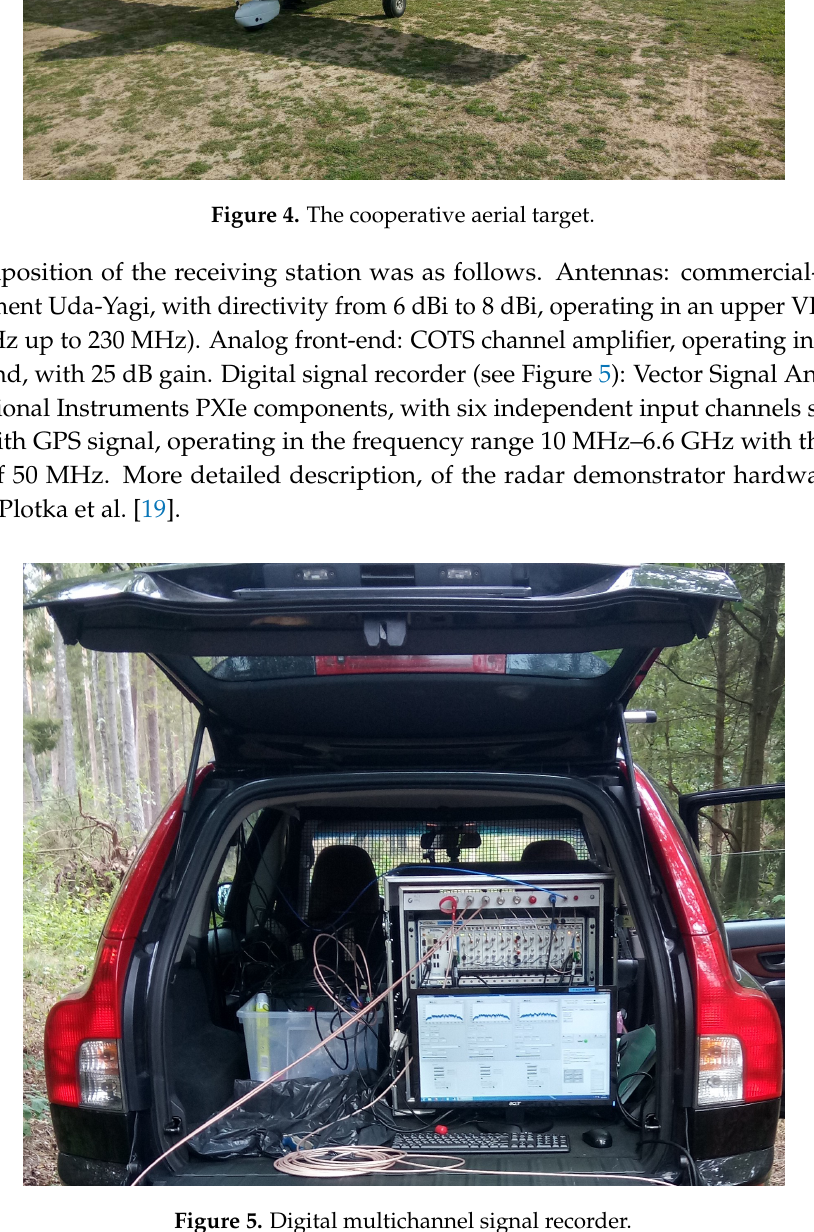
Figure 4. The cooperative aerial target.